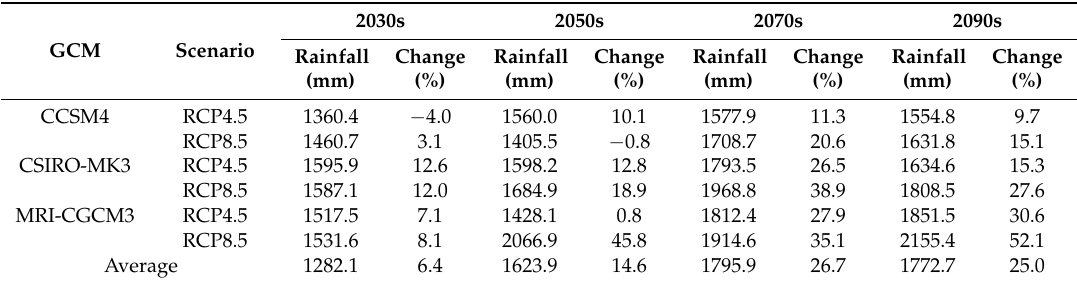
Figure 6. Average monthly precipitations for all climate projections for the 2030s, 2050s, 2070s, 2090s periods and the baseline period of 1982–2005. Table 6. Annual average precipitations for climate projections compared to the baseline period, 1417 mm (1982–2005).